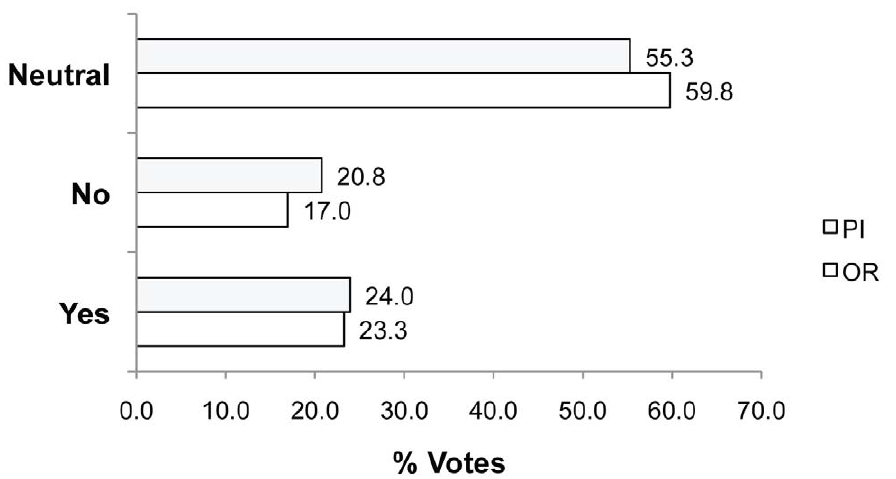
Figure 3. Percent of Yes, No and Neutral votes in response to Q1. Question 1: Is the investigator justified in using animal tissue instead of pursuing the possibility of human tissue use?